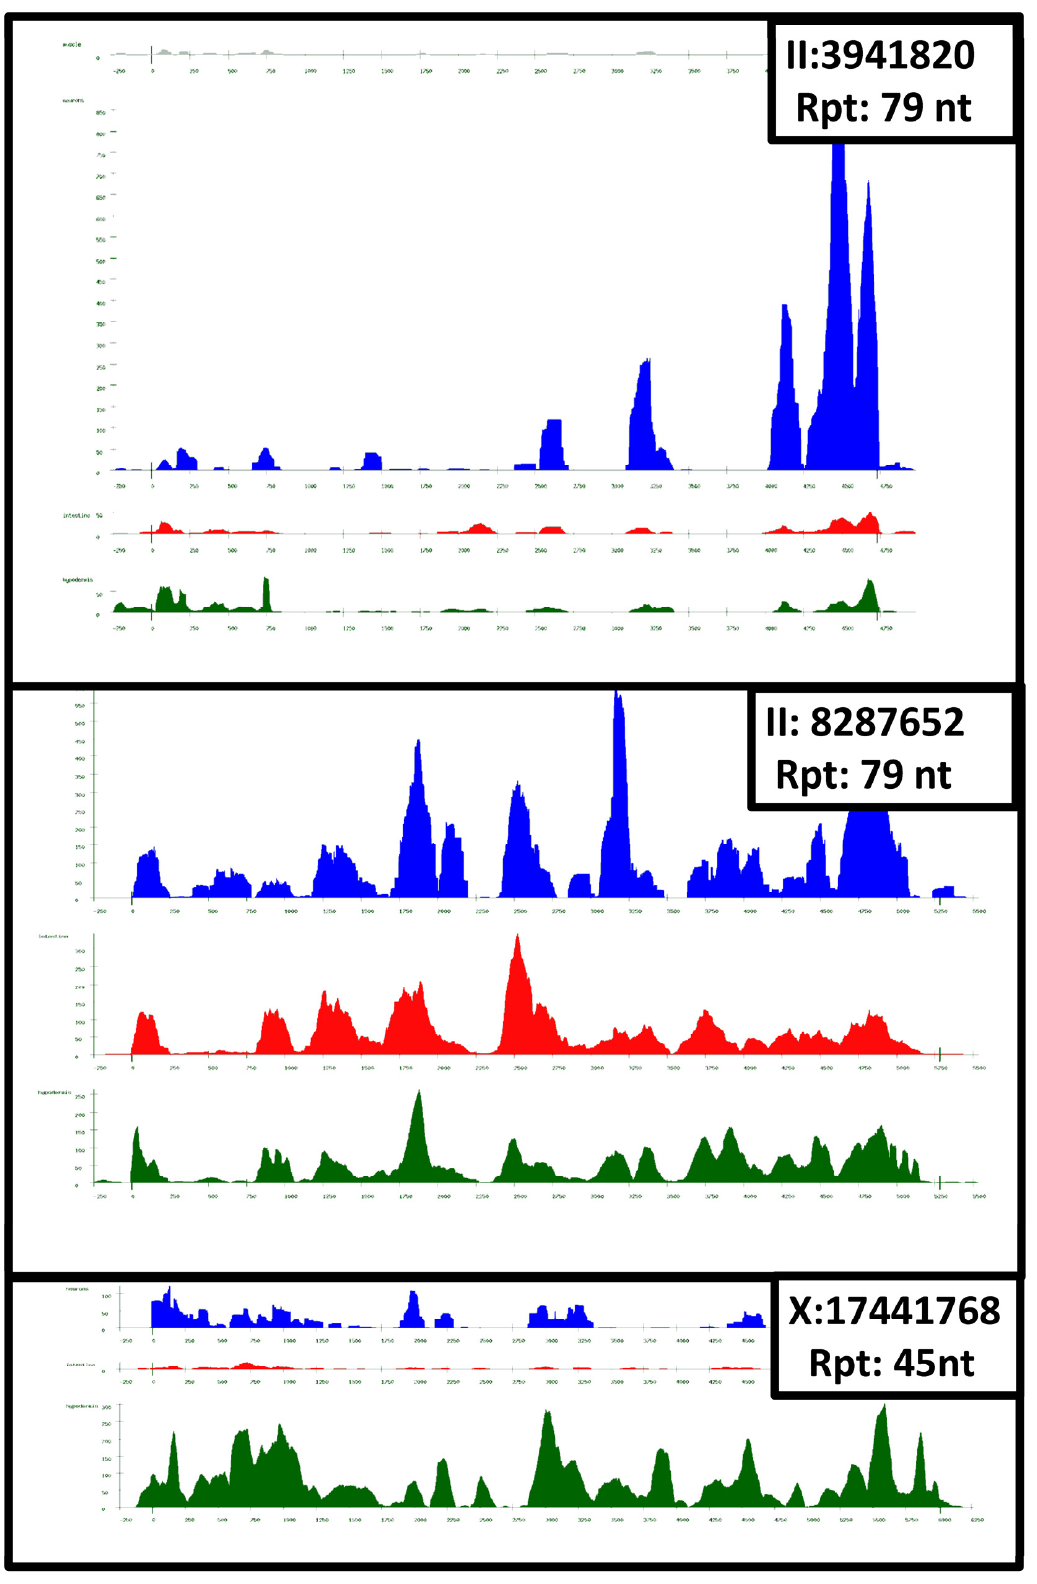
Figure 1. Comparison of transcription in three long satellites (4–6 Kb). Colors in different tissues: grey, muscle; blue, neurons; red, intestine; green, hypodermis. Transcription in muscle is very low in these satellites, it is only shown for the II: 3841820 satellite (upper frame). Further details are given in the main